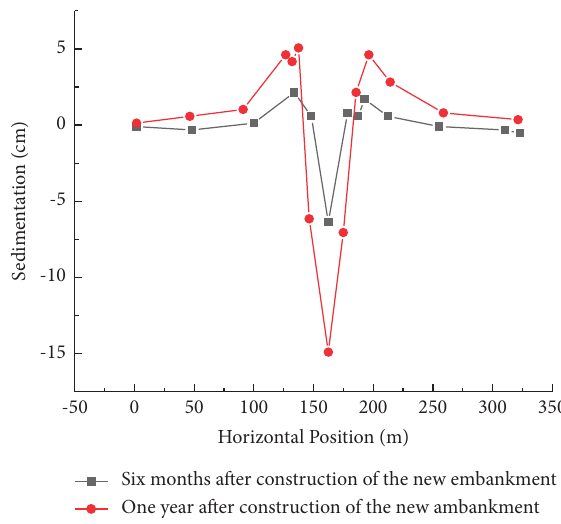
Figure 5: Sedimentation of foundation surface (condition 2).